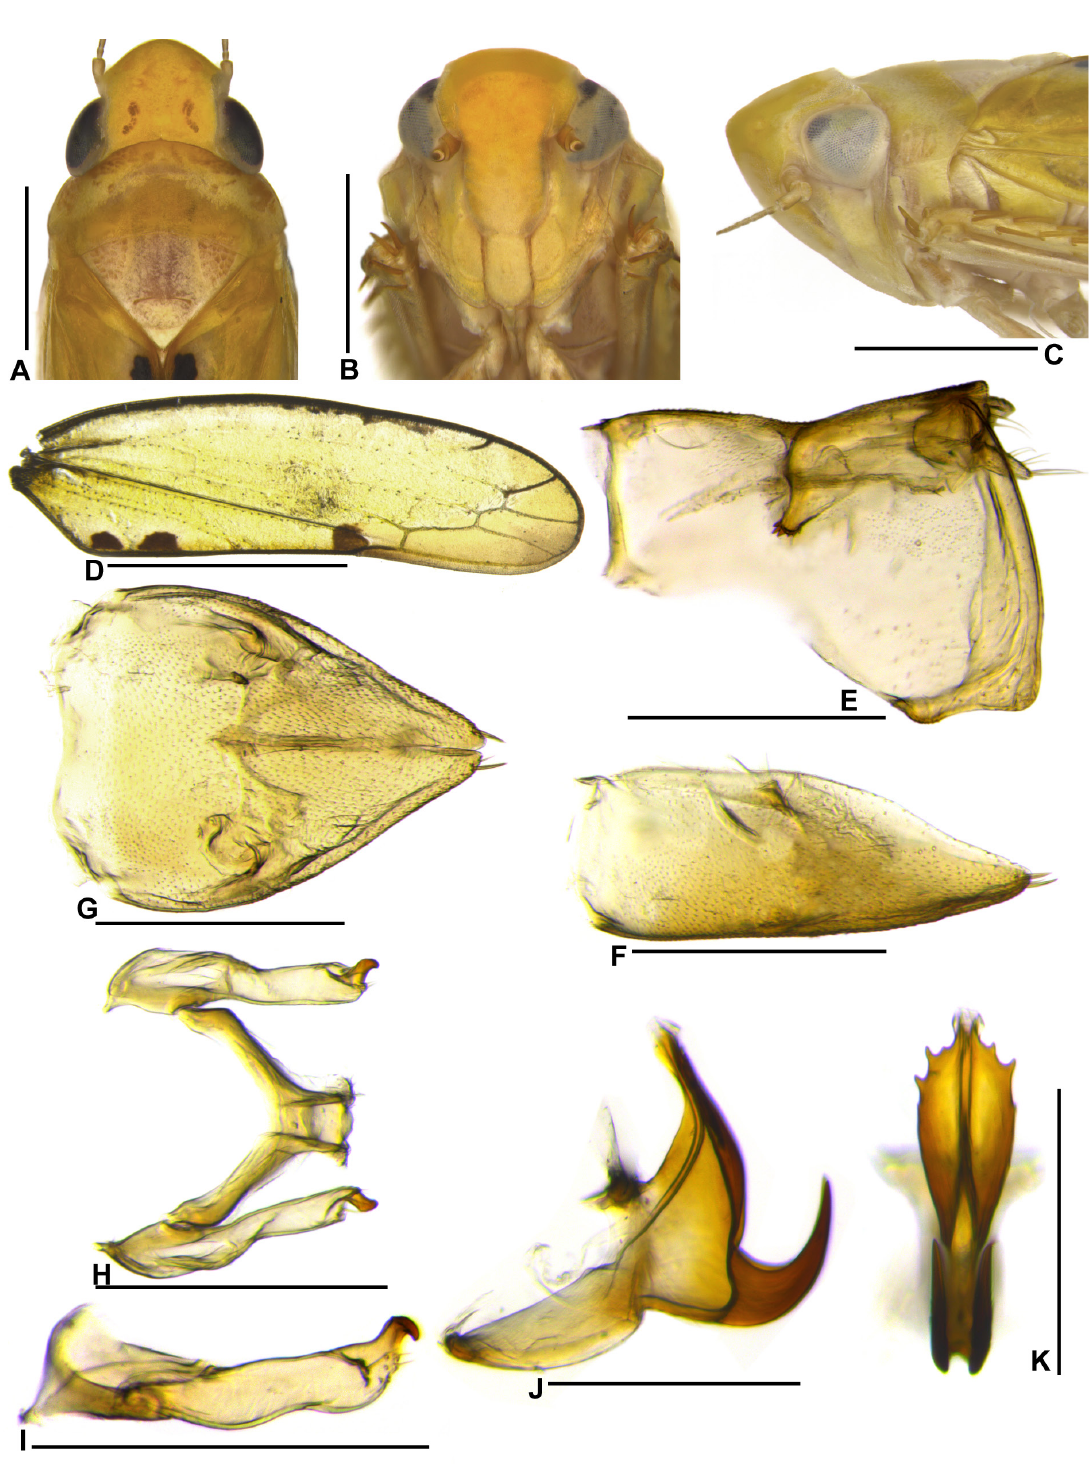
Fig. 8. Takiyaella mejdalanii gen. et sp. nov., ♂, holotype (DZRJ-AUCH #246). A . Head and thorax, dorsal view. B . Head, frontal view. C . Head and thorax, lateral view. D . Forewing. E . Pygofer and anal tube, lateral view. F . Valve and subgenital plate, lateral view. G . Valve and subgenital plate, ventral view. H . Styles and connective, dorsal view. I . Style, lateral view. J . Aedeagus, lateral view. K . Aedeagus, caudal view. Scale bars: A–C = 1.0 mm; D = 2.0 mm; E–I = 0.5 mm; J–K = 0.4